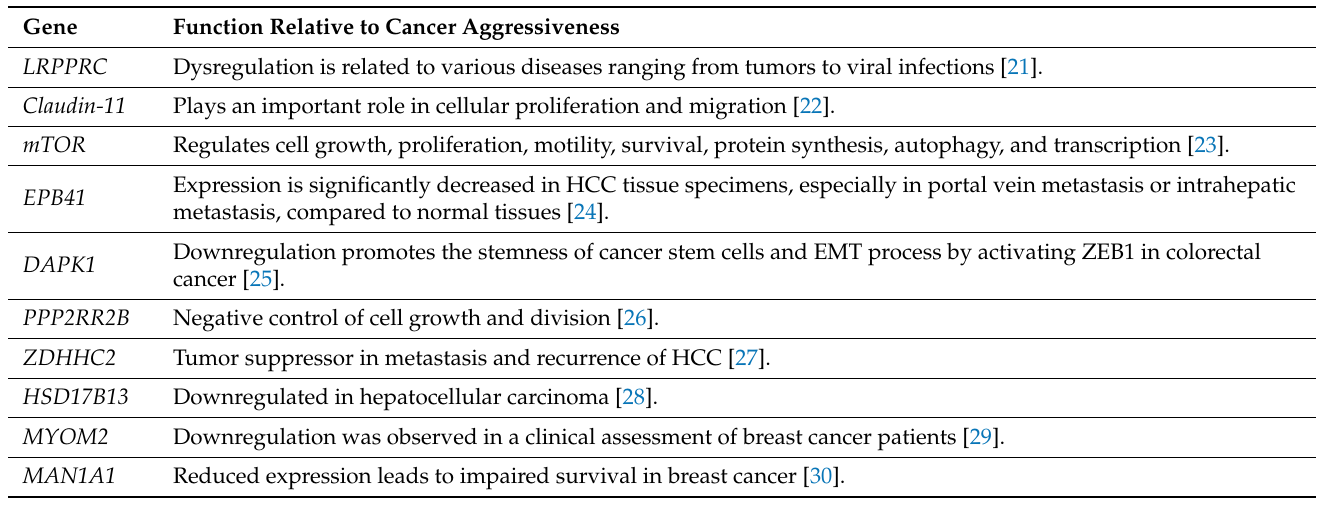
Table 1. Functional relevance of genes identified in DNA methylation chip